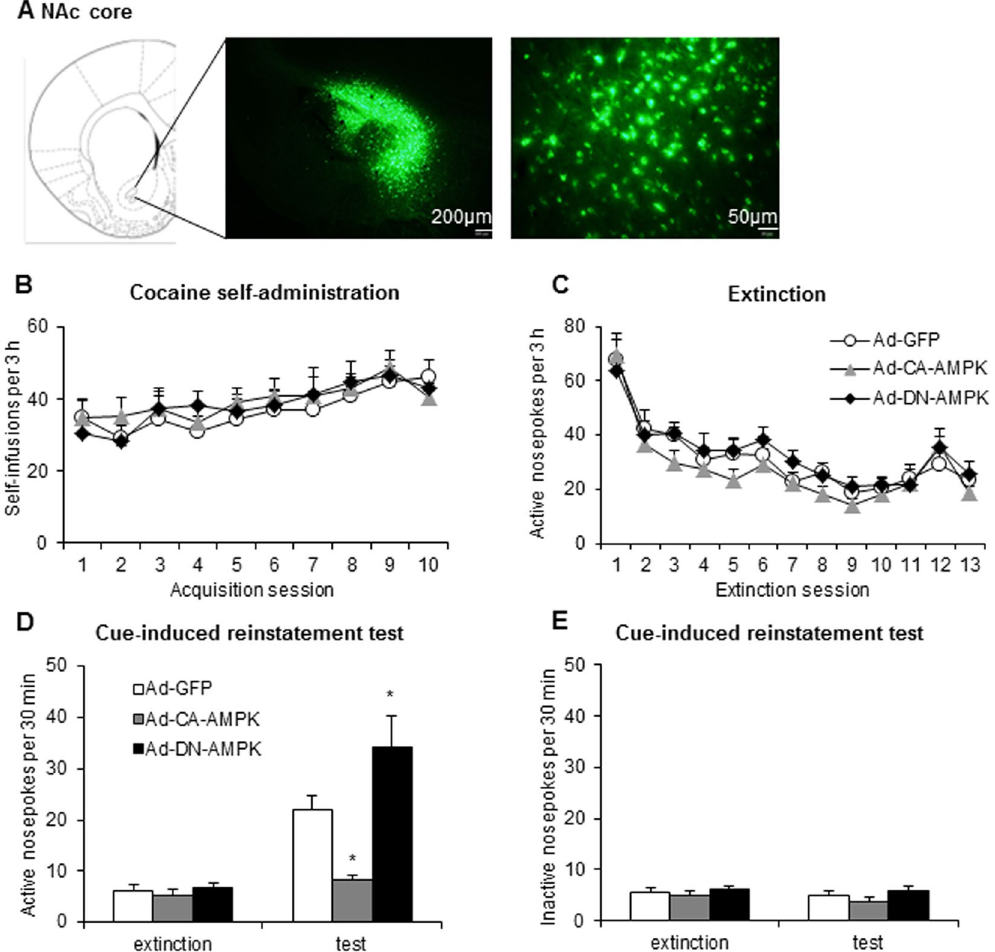
Figure 5. Regulation of AMPK activity in the NAc core by adenovirus-mediated gene transfer altered cue- induced cocaine seeking. ( A ) Representative photographs of the injection sites and coronal brain sections in the NAc core. The figure shows representative micrographs of adenovirus vector-mediated enhanced green fluorescent protein (eGFP; green) after microinjections in the NAc core. Scale bars = 200 μ m (low-magnification images) and 50 μ m (high-magnification images). ( B ) The number of self-infusions during daily 3-h sessions increased in the cocaine self-administration groups ( n = 10 per group). ( C ) Responding during daily 3-h extinction sessions decreased in the cocaine groups. ( D , E ) Average active and inactive nosepoke responding during a 30-min cue-induced reinstatement session before which the rats received intra-NAc core infusions of an adenovirus that expressed constitutively active (CA) or dominant-negative (DN) subunits of AMPK. The data are expressed as mean ± SEM. * p < 0.05, compared with Ad-GFP